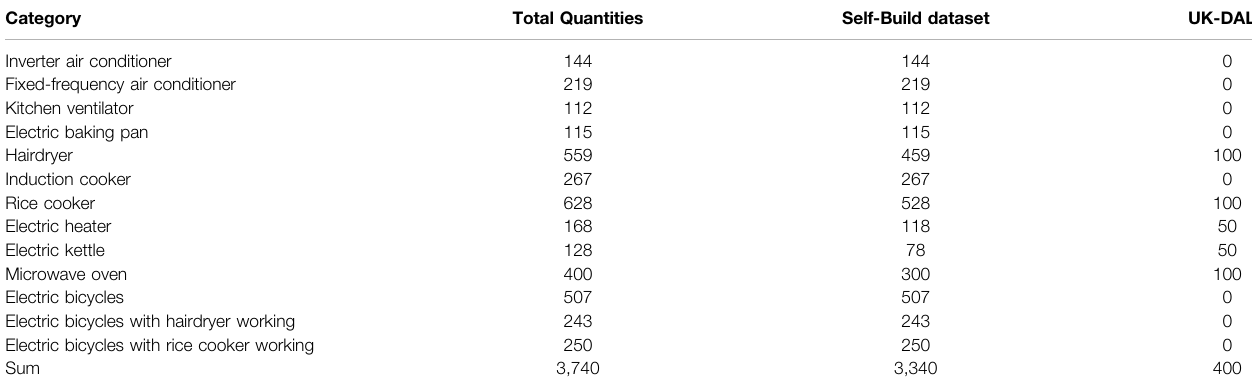
TABLE 2 | Details of the self-built dataset.